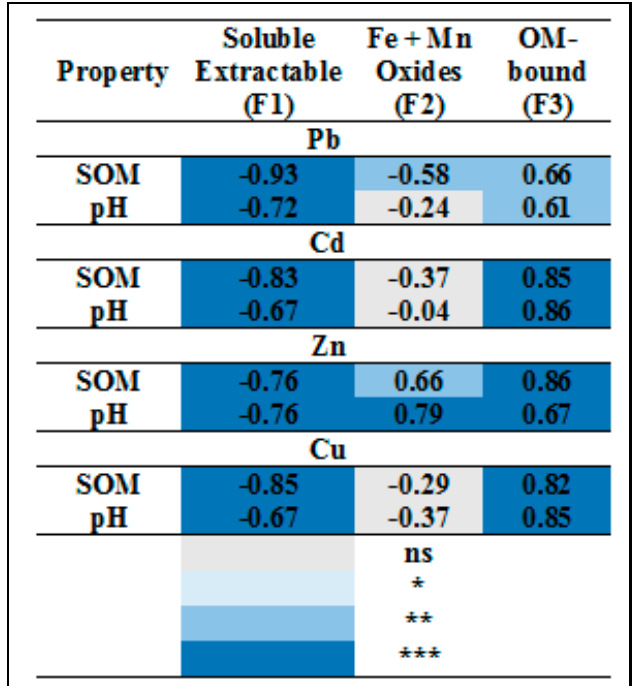
Figure 3. Values representing the correlation coefficient of the acid soluble extractable (F1), Fe and Mn oxides (F2), and organic matter bound (F3) in relation to soil organic matter (SOM) and soil pH. ns, Not significant, * significant, ** highly significant, *** very highly significant.